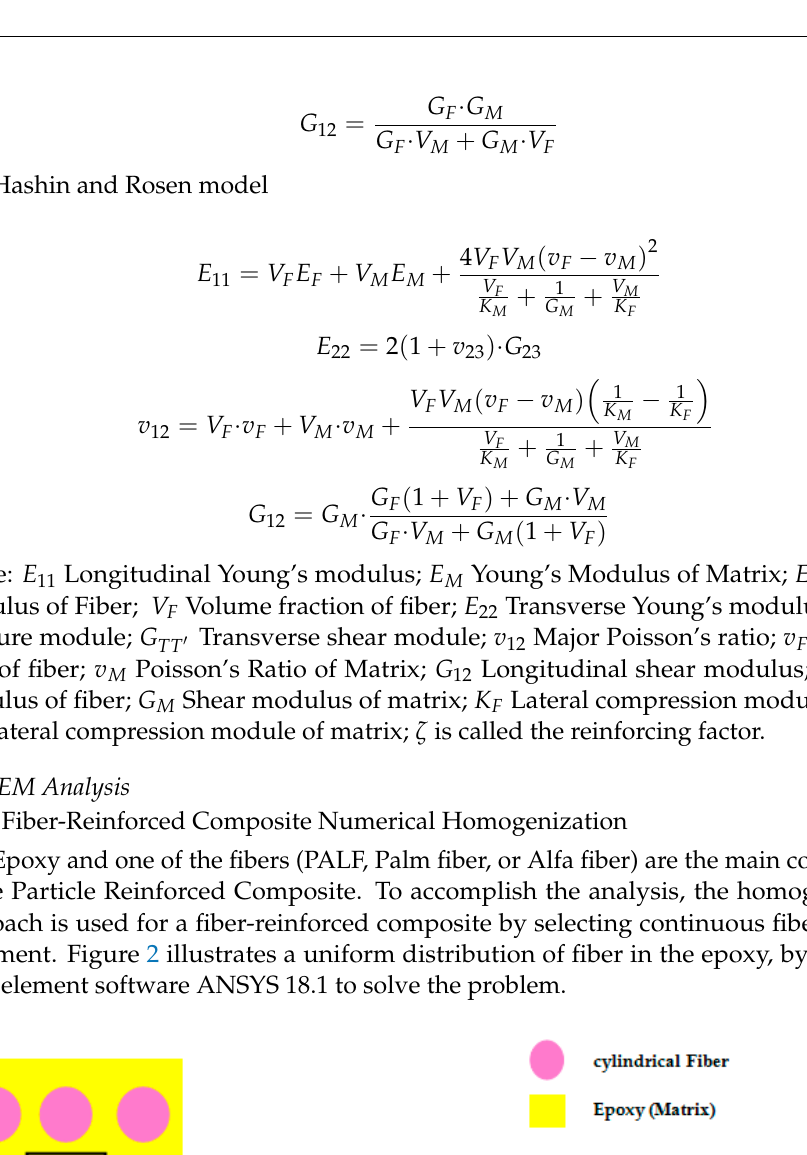
Figure 3. The element used for meshing the finite element models. 2.2.3. Geometry and Finite Element Modeling The representative volume element (RVE) used for the hybrid analysis has the form of a square cube. Due to the symmetry in geometry, loading, and boundary conditions, only one-fourth of the RVE’s cross-section is modeled and studied. As one-fourth of the unit cell is used for FE modeling, the FE model consists of a rectangular prism with di- mensions x = 100 mm, y = 100 mm, and z = 10 mm, with an embedded one-fourth portion of continuous fiber (PALF, Palm, or Alfa fiber) of radius 𝑟𝑓 at one of the square cube’s corners, which is the center of the tubular fiber, where the length of the fiber is taken as 10 mm. As a result, the analysis will be faster and computational time will be lowered. The radius of the fiber is calculated for various weight percentages of the fibers. The weight percentages are converted into volume fractions. Four different volume fractions of fiber have been studied for the analysis, ranging from 15% to 24% with an increment of 3% of the volume fraction of the fiber. Thus, the following (17) is obtained: 𝑟𝑓 = (cid:3496)V𝑓 (cid:3400) 100 (cid:2870) (cid:3400) 4 π (17) where : 𝑟𝑓 is the radius of the cylindrical fiber V𝑓 is the volume fraction of the fiber. Figure 4 gives an example of the converged mesh models of a composite at different volume fractions of natural fibers.